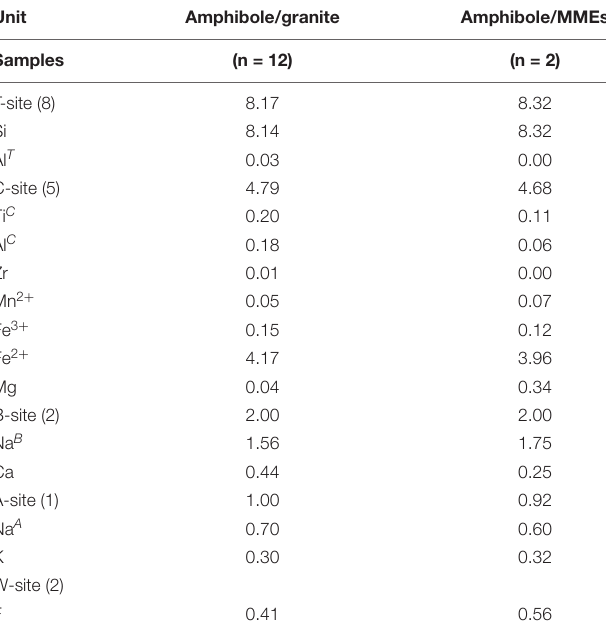
TABLE 4 | Average calculated formulae and cation assignments (in apfu) of amphiboles based on (Locock, 2014). Unit Amphibole/granite